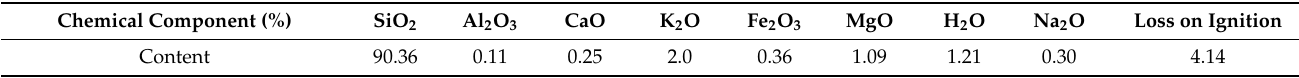
Table 5. Main chemical composition of silica powder.